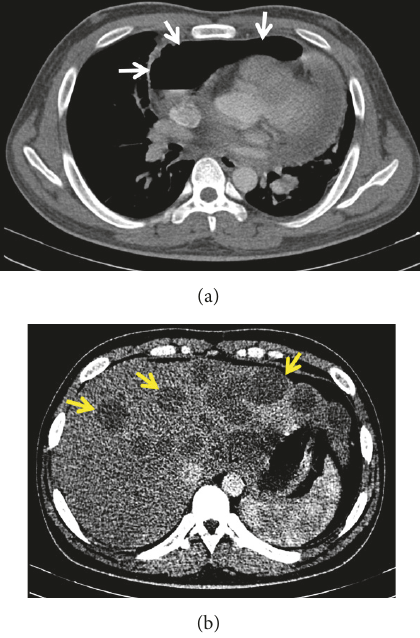
Figure 7: CT scan images. (a) Cross-sectional cut of the heart and pericardium revealed an air-fluid level within the pericardial sac (white arrows). (b) Cross-sectional cut of the liver showed multiple hypodense nonenhancing foci (yellow